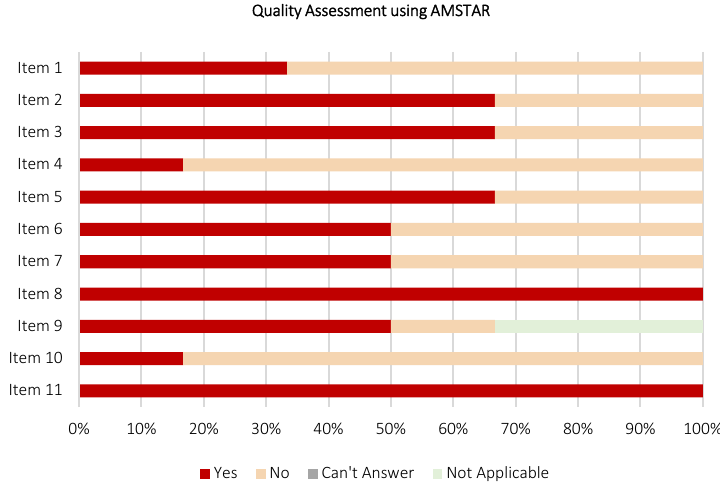
Figure 16. Quality assessment on six included review works (systematic review) using AMSTAR appraisal tool.